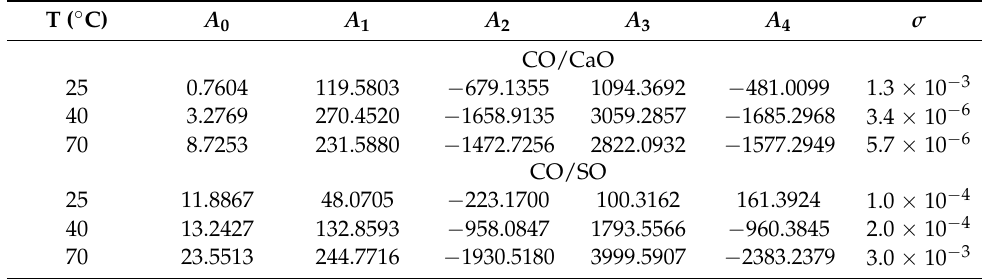
Table A3. Coefficients A i and standard deviation ( σ ) obtained from the Redlich–Kyster adjustment for the viscosity deviation ( ∆ ln( η )) property of the binary oil